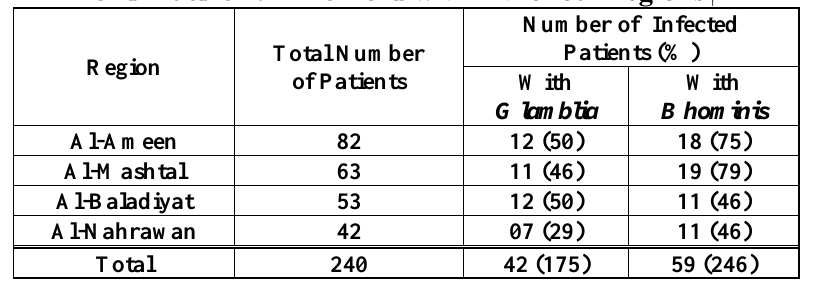
Table (1): Number and percentage of patients infected with G lamblia and B hominis within the four